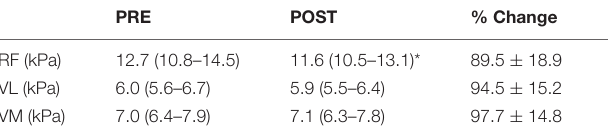
TABLE 3 | Changes in the shear elastic modulus (Experiment